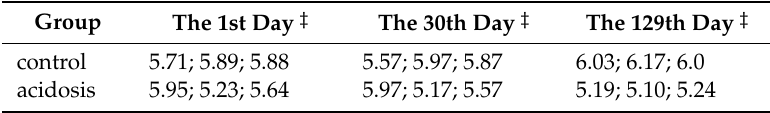
Table 1. Ruminal pH of normal and acidosis